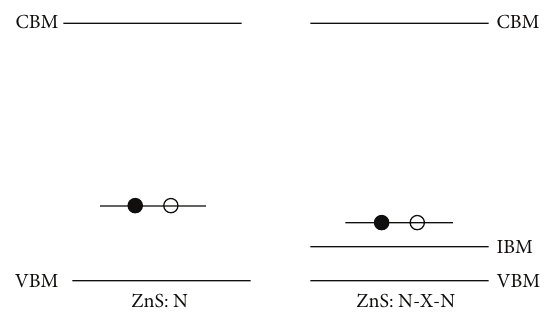
Figure 2: Schematic illustration of the energy level for single doping of N and codoping with N and X (Al, Ga, and In) in